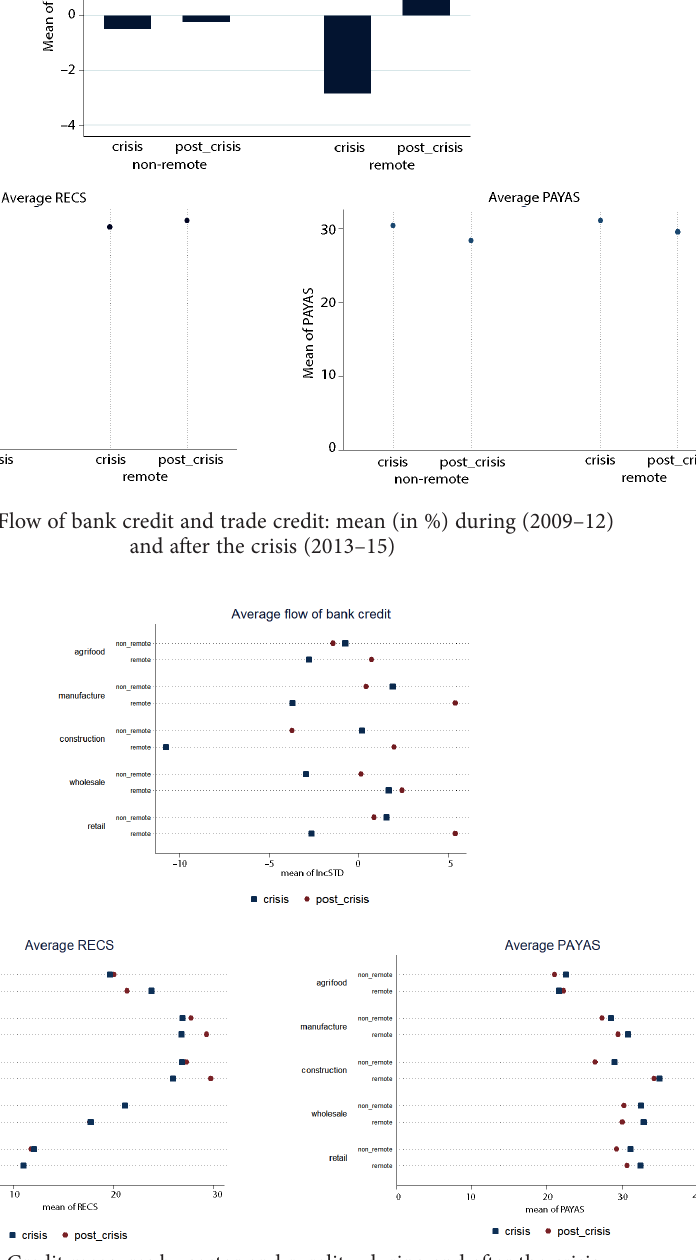
Figure 4. Credit measures by sector and rurality, during and after the